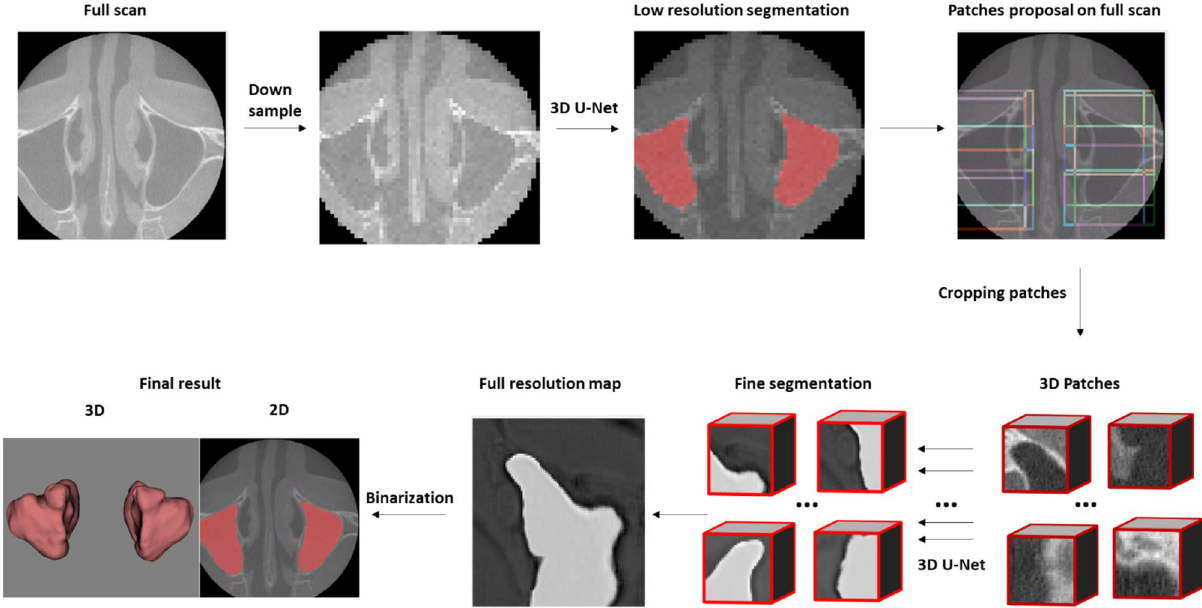
Figure 2. Working principle of the 3D U-Net based segmentation model.